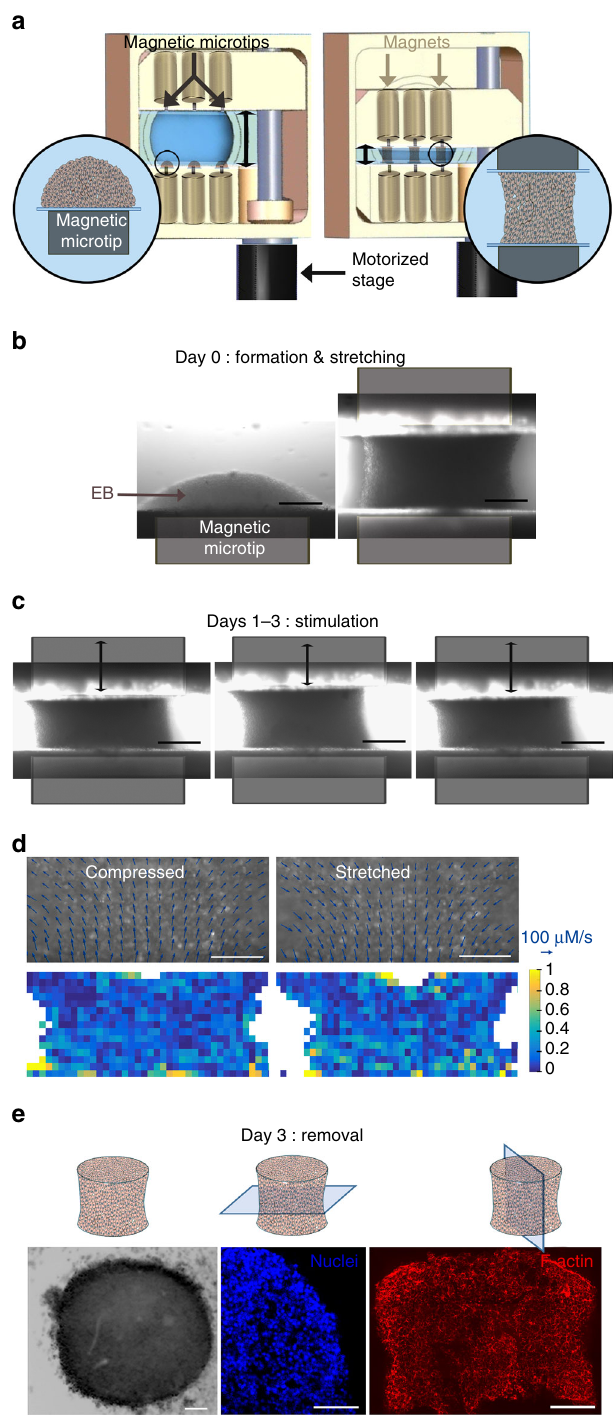
Fig. 5 Magnetic stretcher: formation and stimulation of EBs. a Diagram of the magnetic stretcher device developed. Three EBs could be created on magnetic microtips (magnetized by permanent magnets), and then could be stretched/stimulated by approaching another 3 microtips (also magnetized by permanent magnets). The system is motorized to realize micrometer displacement of the second mobile magnetic microtips system. b Typical images of the fi rst phases on day 0: EB formation and stretching. Scale bar : 200 µ m. c Typical images of the cyclic stimulation (here at days 1-3). Scale bar: 200 µ m. d Fluorescence images of membrane-stained cells in compressed and stretched EBs (10% imposed strain) are overlaid with velocity vectors extracted from PIV analysis ( arrow bar scales for a speed of 100 µ m/s). Only one fourth of the vectors are represented for easy reading. Scale bar : 100 µ m. The divergence of the velocity fi eld (for stretching) or its opposite (for compression) representative for the strain rate is mapped in both cases. For compression and stretching steps the mean effective strain rate sensed by cells is calculated at 0.32 ± 0.08 and 0.32 ± 0.06 s − 1 , respectively. e EB sampling on day 3 (here shown for a “ cyclic ” condition): Optical microscopy right after magnet removal and fl uorescent imaging (DAPI staining, middle; F-actin staining, right) of 16- µ m cryosections in the perpendicular and parallel direction of the tissue axis. The nuclei image shows a homogeneous cell density in the center of the EB, while F-actin is homogenous whatever the localization of the cell inside the stretched EB. Scale bar : 100 µ m. All EBs were formed with 10,000